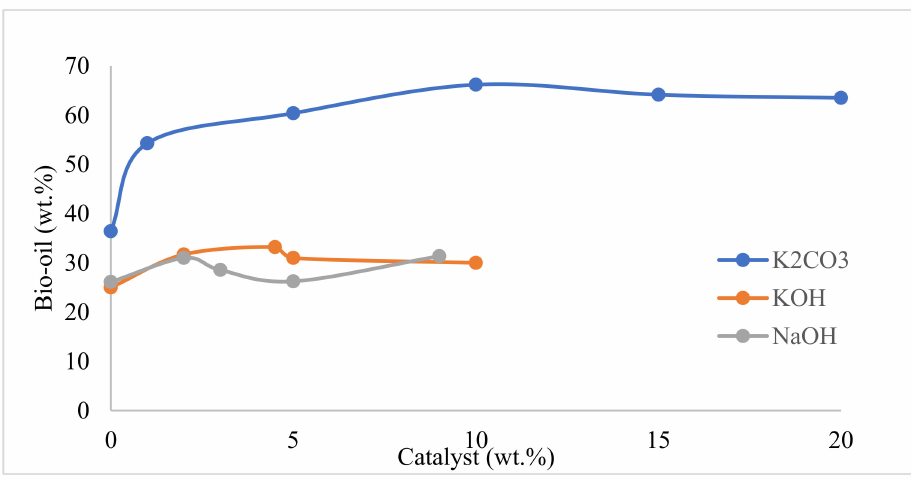
Figure 8. Effect of homogeneous catalyst concentration (alkali) on the yield of